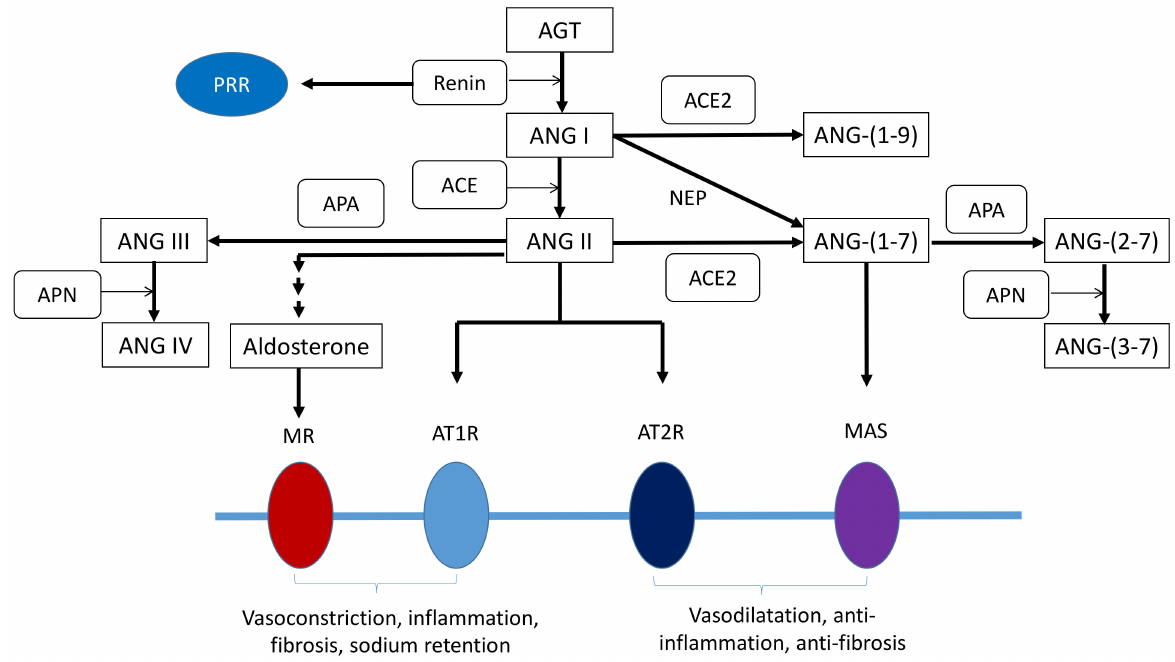
Figure 1. Schema outlining the renin-angiotensin-aldosterone system cascade including the renal effects of receptor stim- ulation. AGT, angiotensinogen; ACE, angiotensin-converting enzyme; ACE2, angiotensin-converting enzyme 2; ANG, angiotensin; ANG I, angiotensin I; ANG II, angiotensin II; ANG III, ANG-(2–8); ANG IV, ANG-(3–8); APA, aminopeptidase A; APN, aminopeptidase N; AT1R, angiotensin II type 1 receptor; AT2R, angiotensin II receptor; MAS, angiotensin-(1–7) recep- tor MAS; MR, mineralocorticoid receptor; NEP, neutral endopeptidase; PEP, prolyl endopeptidase; PRR, (Pro)renin-